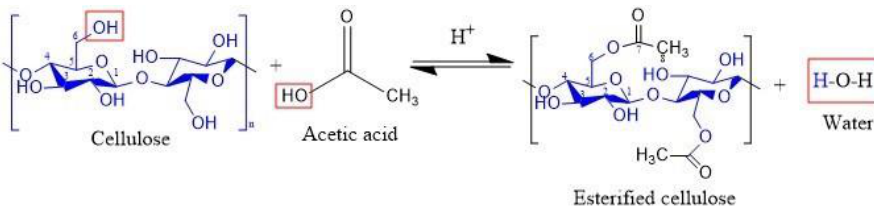
Figure 12. Representation of esterified cellulose obtained by a Fischer esterification reaction.